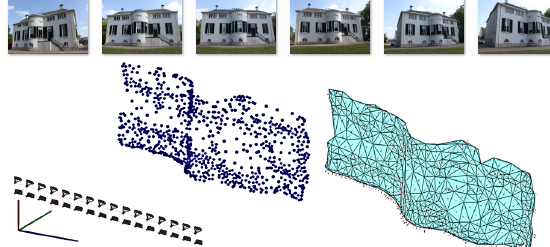
Figure 5. The facade case and its initial imaging